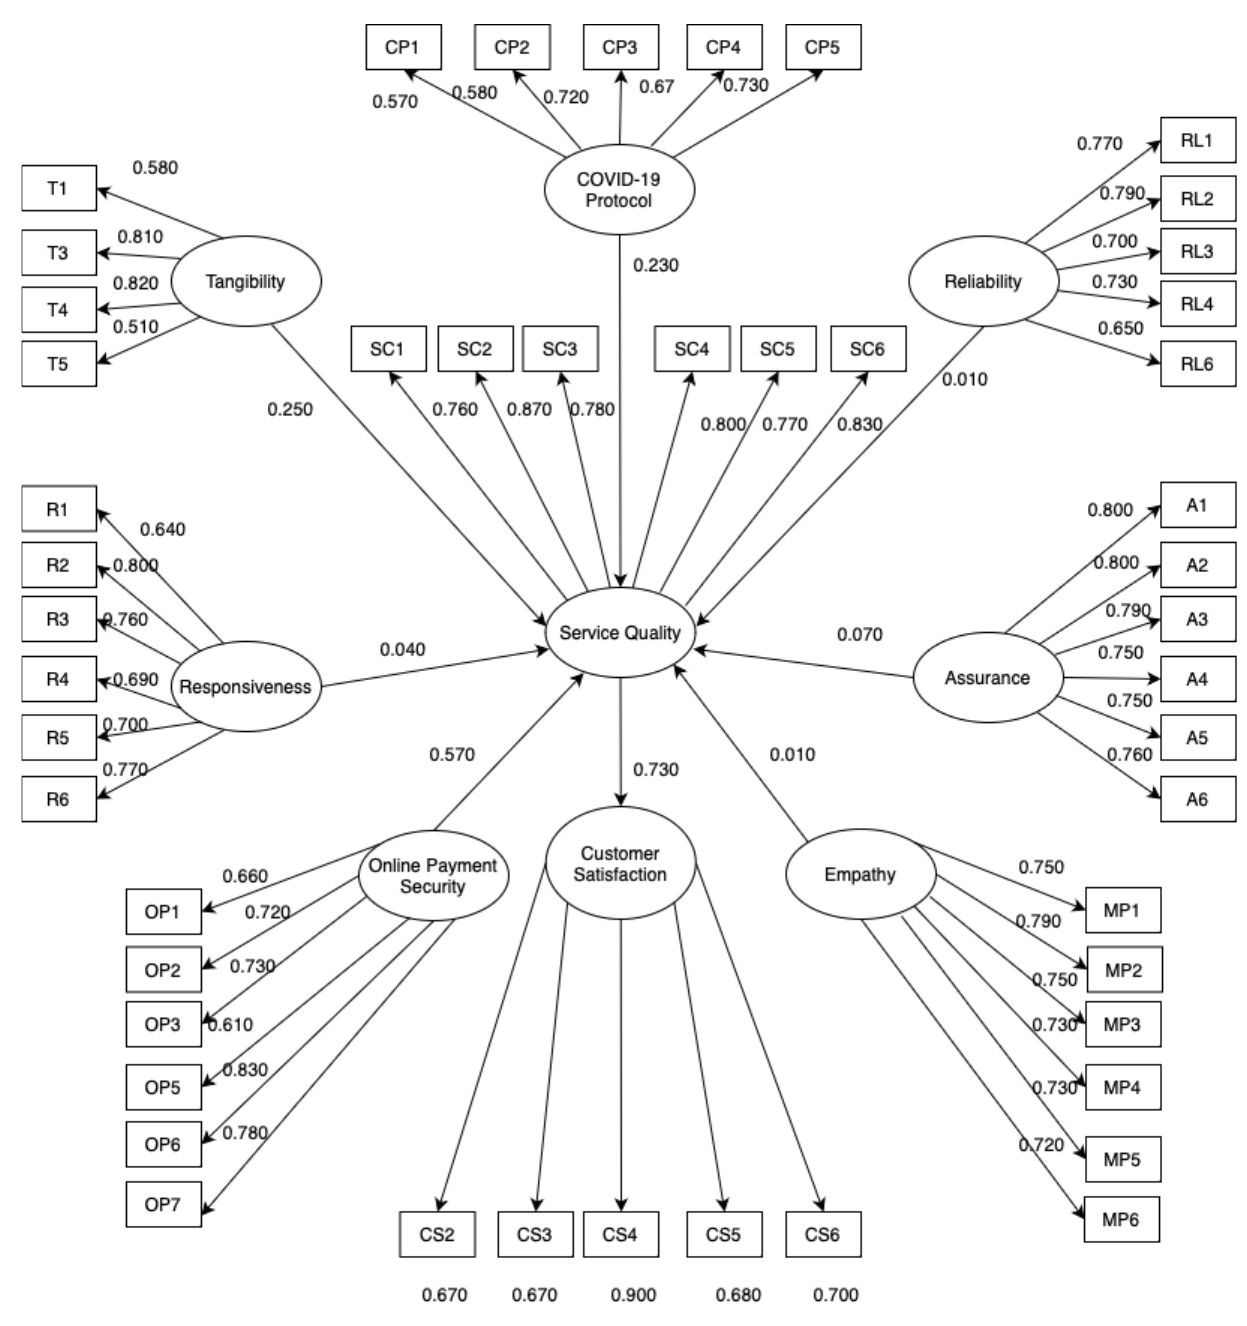
Figure 5. Final SEM with indicators for evaluating service quality.